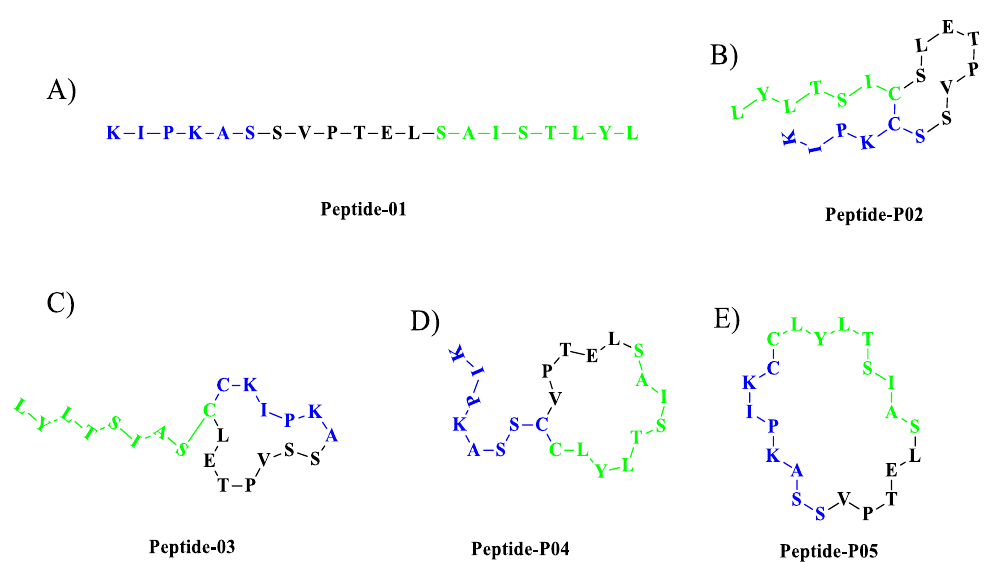
Figure 1. Schematics of designed peptides: ( A ) P-01: Linear knuckle epitope peptide; ( B ) P-02: Cyclic peptide, where the N-terminal and the C-terminal region’s (green) active sites were outside the cyclic structure; ( C ) P-03: The N-terminal was involved (blue) in the cyclic structure, while the C-terminal was free and outside of the cyclic structure; ( D ) P-04: The C-terminal (green) was involved in the cyclic structure, while the N-terminal was free and outside of the cyclic structure; ( E ) P-05: Both the N-terminal (blue) and the C-terminal (green) were involved in the cyclic structure. Table 1. The molecular weight of the bone morphogenetic protein 2 (BMP-2) linear and cyclic pep- tides.